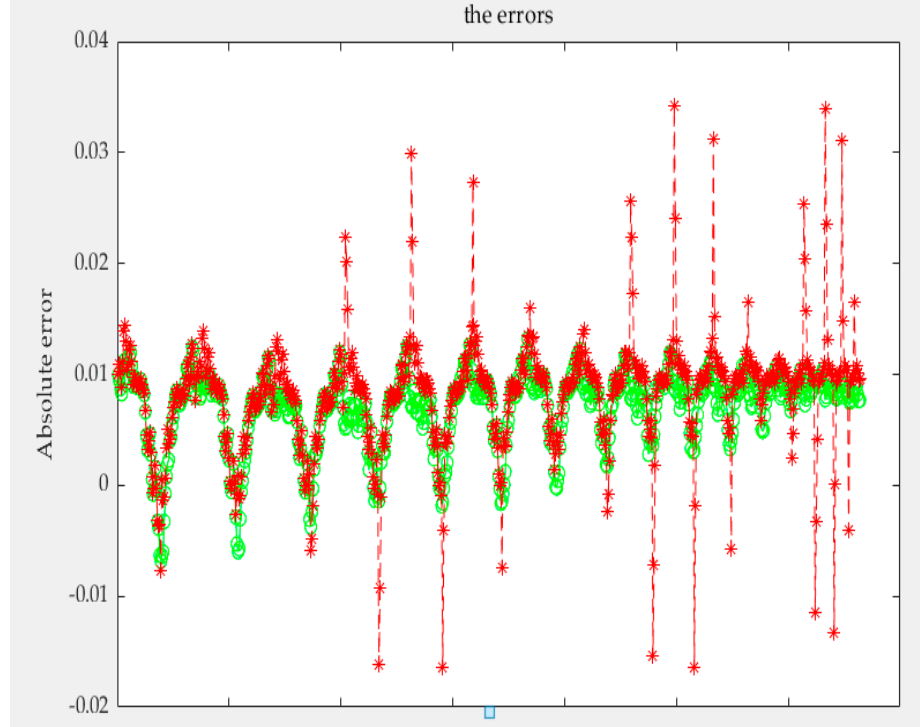
Figure 19. Errors of the second kind sensor for the sparse data.